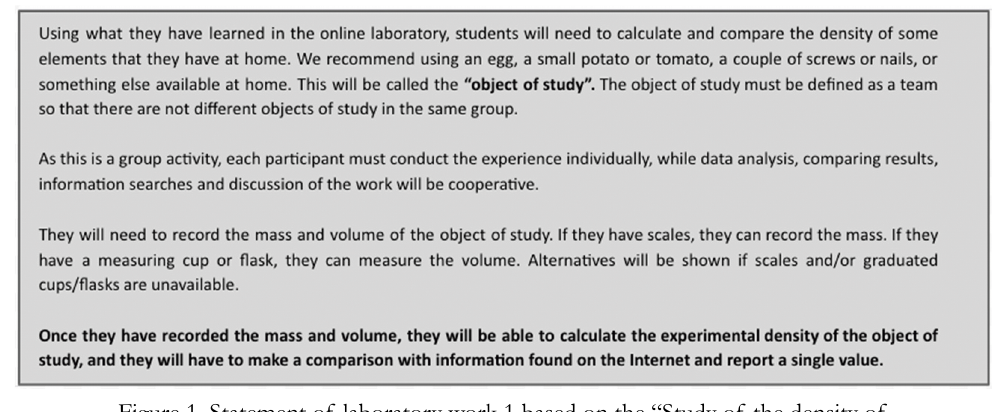
Figure 1. Statement of laboratory work 1 based on the “Study of the density of irregular bodies at home”